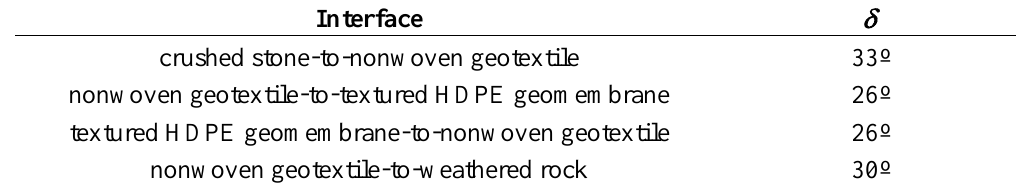
Table 1. Cover system interfaces and interface shear strength angle  , adapted from